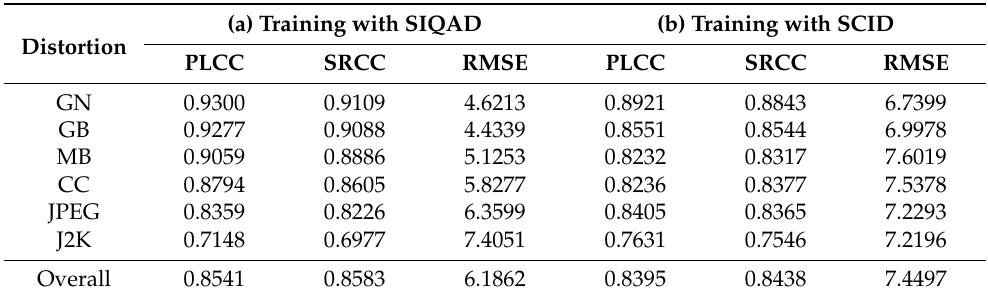
Table 7. Cross validation results of the proposed DAML with six types of distortion on SIQAD and SCID.